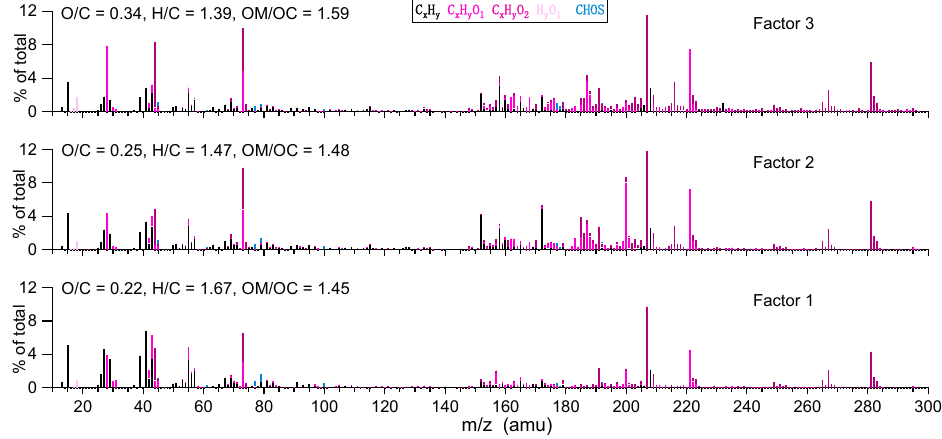
Figure 7. High-resolution mass spectra of the PMF-resolved factors (factors 1 to 3 are the names of